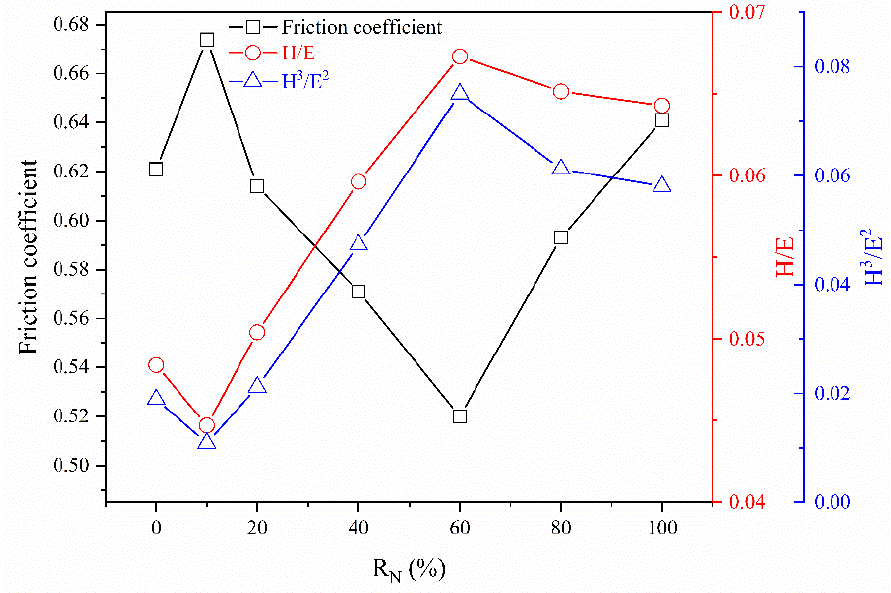
Figure 9. Friction coefficient, H/E, and H 3 /E 2 of (CrHfNbTaTiVZr)N coatings deposited at various R N .